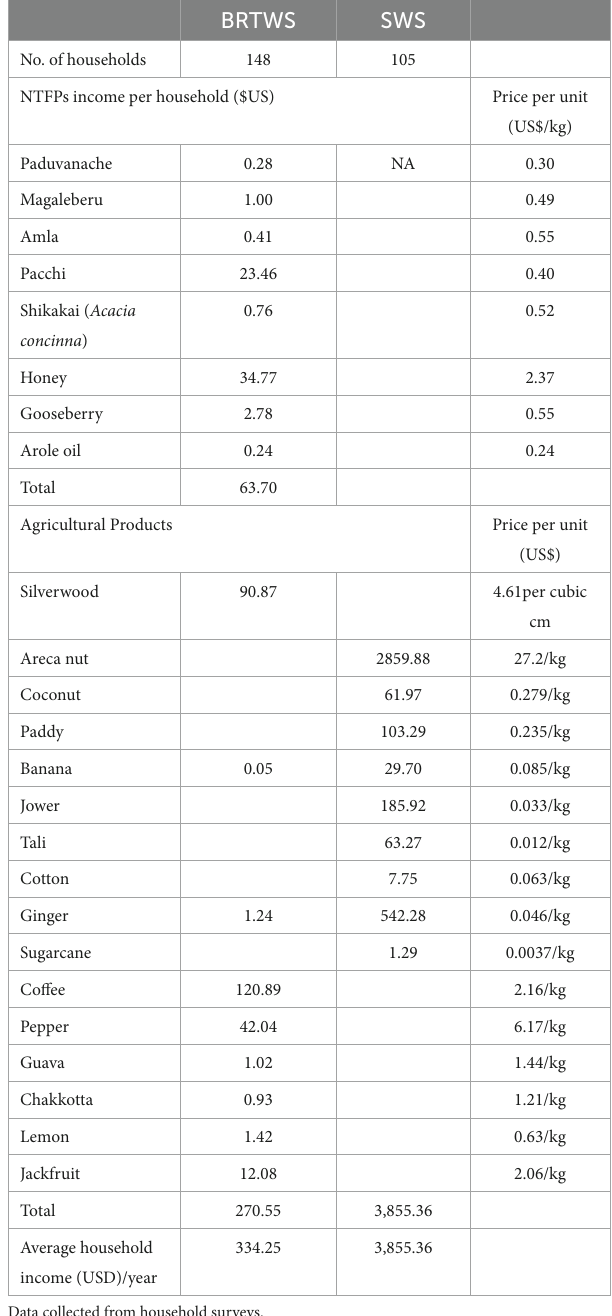
TABLE 2 Economic value of NTFPs and Agricultural production (US$/ year) for surveyed households of Adivasi communities residing in the BRTWS and